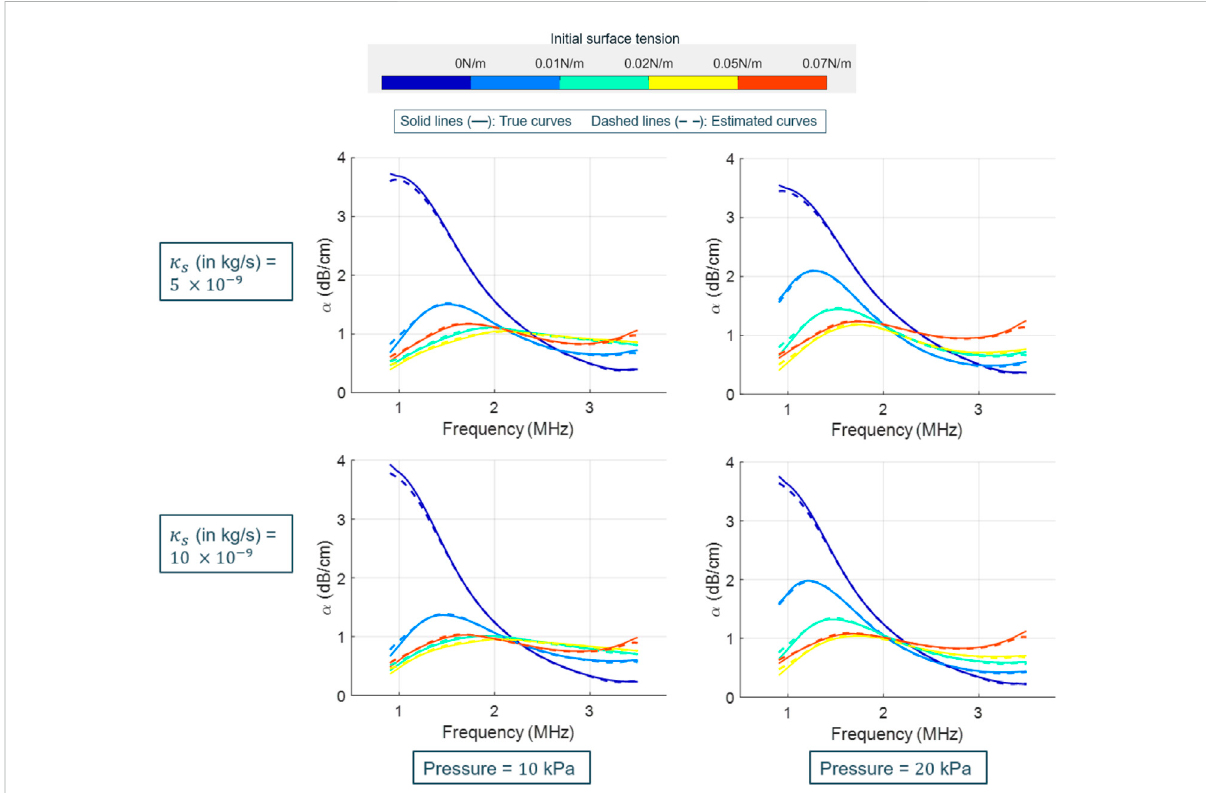
FIGURE 6 Attenuation spectra for SonoVue with χ = 1 N/m, as a function of the initial surface tension (values shown in the colorbar). In each plot, the true (solidlines)andLLSestimated(dashedlines)pro fi lesaredisplayed.Theshownplotsareforvaryingshellviscosities(row-wise)andacousticpressures (column-wise). The estimated spectra is the mean computed over the estimator ’ s results on 10 different